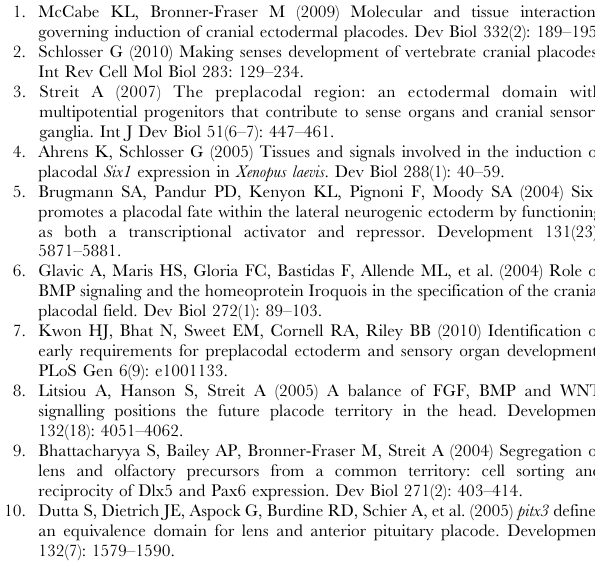
morphants relative to controls (p = 0.10) (see Table 1). (TIF) Figure S5 Elevating Fgf does not rescue the cell migration defect in itga5 morphants. Maps of cell trajectories in pax2a:GFP/ + ; hs:fgf8/ + and neuroD:GFP/ + ; hs:fgf8/ + embryos injected with itga5 -MO. To assist in cell-tracking, embryos were also injected at the one-cell stage with cmv:GFP . Embryos were heat shocked at 11 hpf and filmed from 11.5–14.5 hpf. Cells were tracked by RFP expression in the pax2a:GFP background, or by GFP expression in the neuroD:GFP background. Initial boundaries of transgenic GFP expression are shown in purple and black, whereas final boundaries are shown in green and red. (TIF) Movie S1 Migration of cells in a pax2a:GFP control embryo. In addition to GFP expression, the embryo was injected at the one-cell stage with cmv:RFP plasmid DNA, providing mosaic expression to facilitate cell-discrimination within the otic placode. The movie runs from 11.5 hpf to 14.5 hpf. (MOV) Movie S2 Migration of cells in a pax2a:GFP embryo injected with itga5 -MO. In addition to GFP expression, the embryo was injected at the one-cell stage with cmv:RFP plasmid DNA, providing mosaic expression to facilitate cell-discrimination within the otic placode. The movie runs from 11.5 hpf to 14.5 hpf. (MOV) Movie S3 Migration of cells in a neuroD;EGFP control embryo. The movie runs from 11.5 to 14.0 hpf. (MOV) Movie S4 Migration of cells in a neuroD;EGFP embryo injected with itga5 -MO. The movie runs from 11.5 to 14.0 hpf.